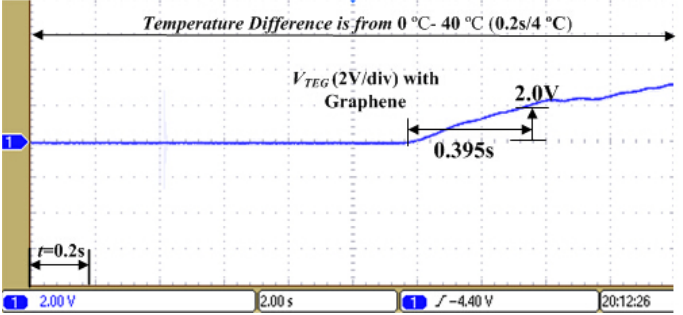
Figure 13. Measured waveform of the output voltage (Channel 1) of the TE board with graphene attached as the thermally conductive material.